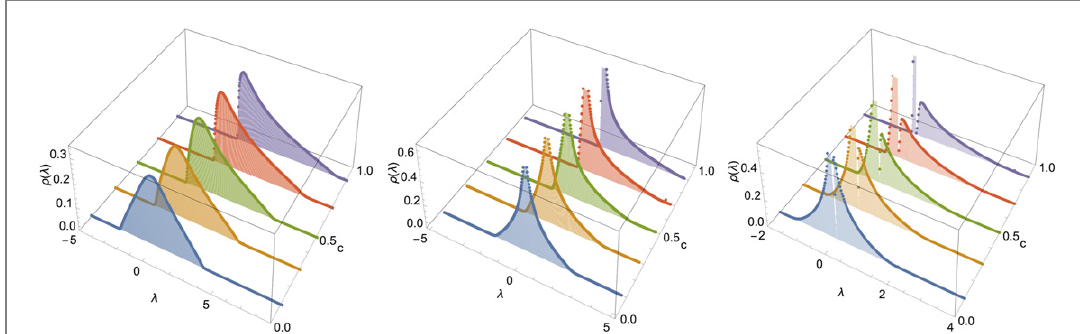
Figure2. Comparison between the theoretical results (markers) and numerical diagonalization (histograms filling the plots) for d = 12 a values of c from 0.1 until 0.9. The parameter α , that controls the rectangularity of the matrix, is fixed to the values α = 3 (left figure), α = 1 (middle figure), and α = 0 . 3 (right